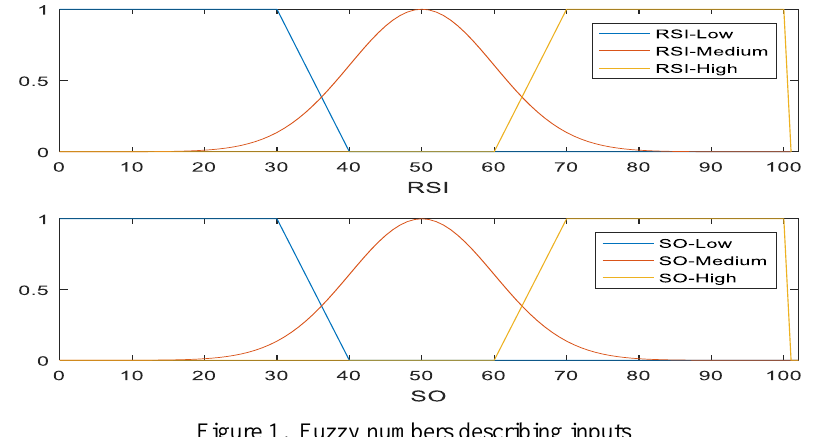
Figure 1. Fuzzy numbers describing inputs